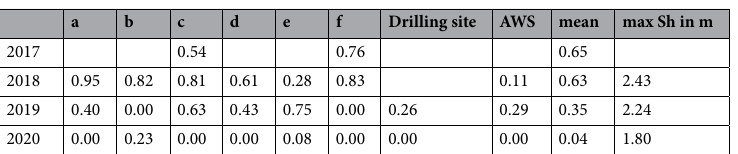
Table 1. Annual surface ablation measured at stakes a-f and at the drilling site [m ice] as well as the ice ablation and maximum snow height (max Sh) from the sonic ranging sensor at the automatic weather station (AWS). The AWS values are generally too low due to data gaps towards the end of the ablation seasons (Fig.